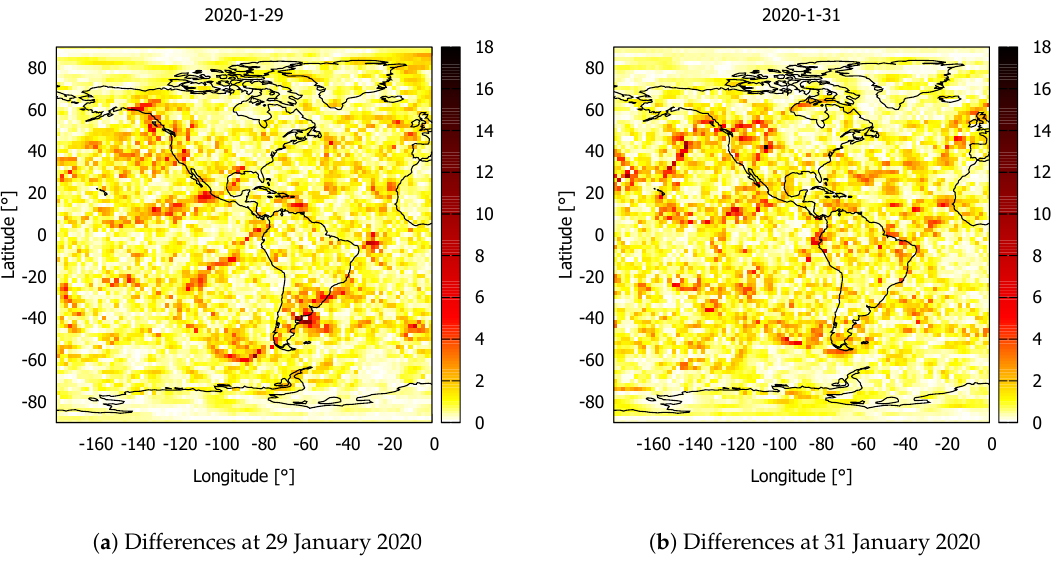
Figure 2. Mean differences in wind speed for 29th ( a ) and 31st ( b ) January 2020 between a six-hour GFS forecast and the corresponding GFS model output (six hours after the forecast has been calculated). On a global average, the GFS modeled mean wind speed deviates 3 ms − 1 from the AMDAR output of the same